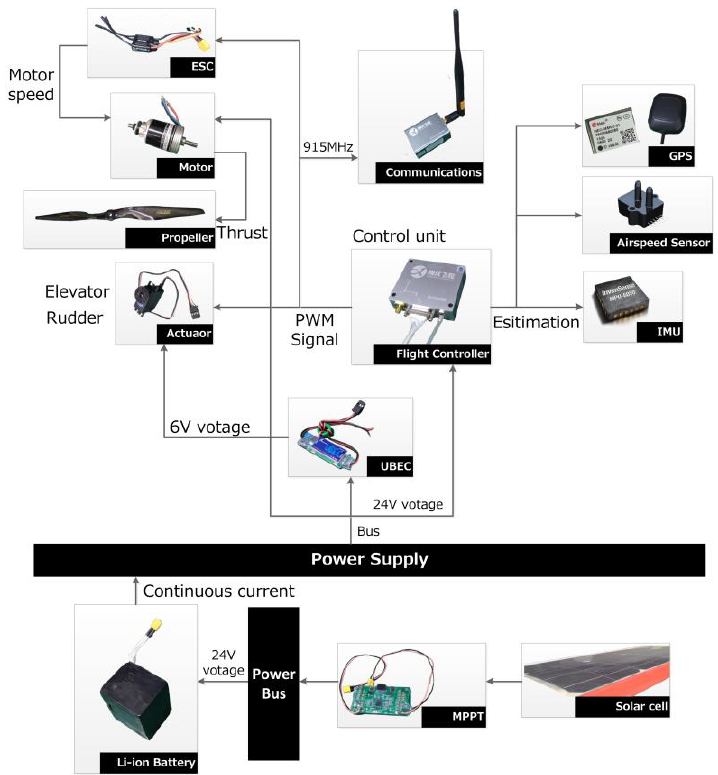
Figure 3. Topological system on overview of the solar UAV.